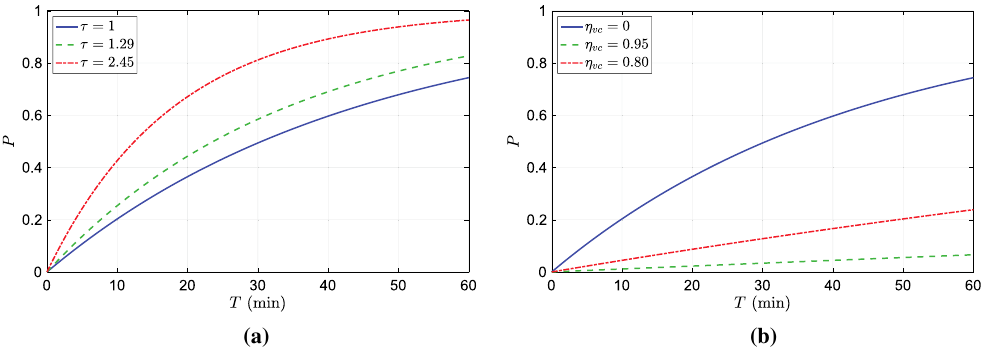
Figure 7. ( a ) comparison of infection probability over time of different strains of SARS-CoV2. ( b ) Comparison of infection probability of vaccinated and unvaccinated cases.